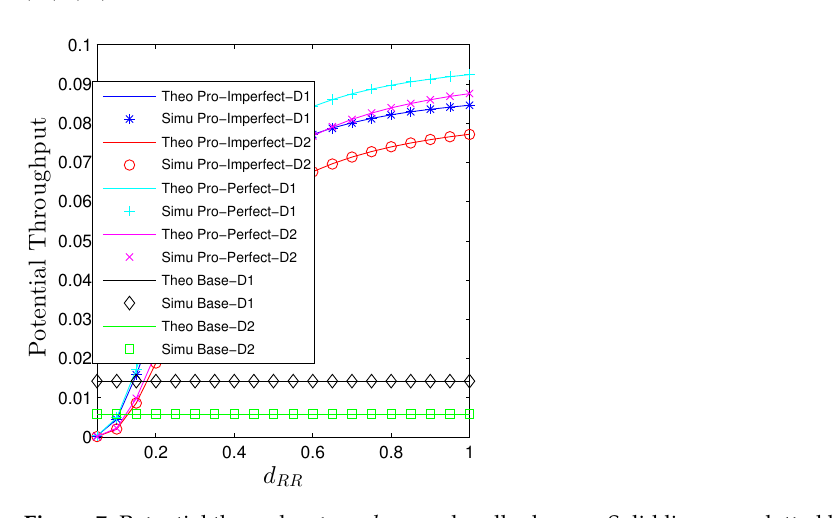
Figure 7. Potential throughput vs. d m , m under all schemes. Solid lines are plotted by employing (13) while markers are Monte Carlo